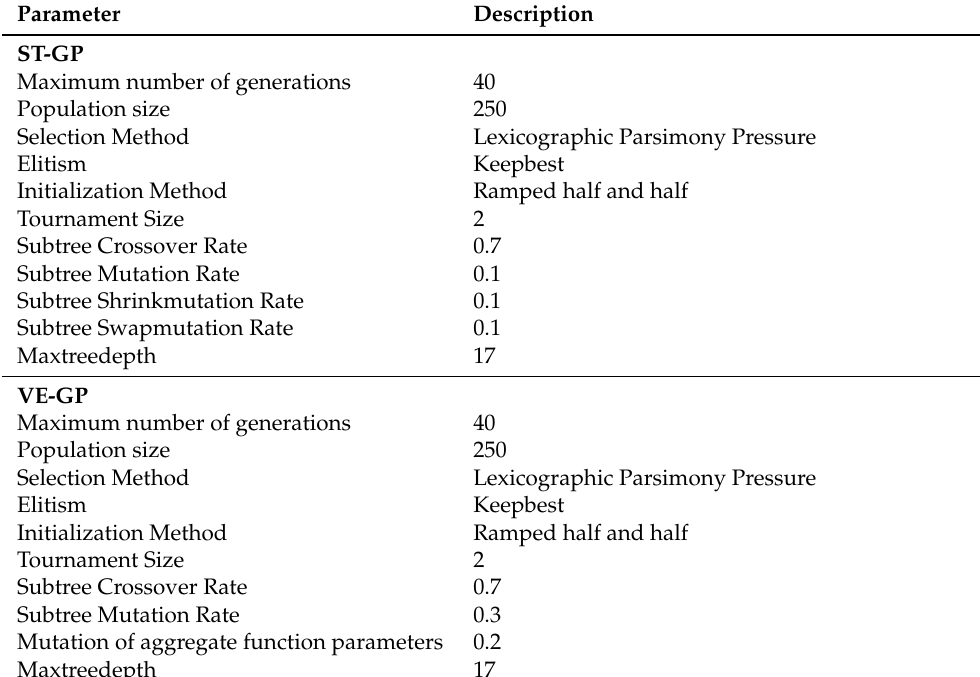
Table 5. Parameters used to perform